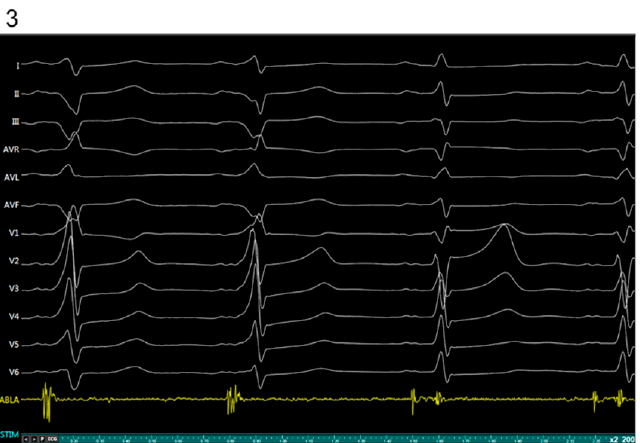
Figure 1. ( 1A ) During EPS, delta wave and QRS are (+) in lead V1, and ( − ) in inferior leads suggesting a left posteroseptal accessory pathway. Mapping the MA from the left side (retroaortic), showed earliest ventricle activation at the beginning of the delta wave. ( 1B ) Mapping the MA from inside the coronary sinus showed the earliest ventricle activation before the delta wave. ( 2A ) Venous angiography at the persistent left superior vena cava showed contrast flowing to the right atrium through a dilated coronary sinus. ( 2B ) Ablation catheter located at the point of effective ablation deep inside the dilated coronary sinus. ( 3 ) After mapping inside the giant CS, RF application during sinus rhythm at the earliest ventricular activation point removed the accessory pathway potential, showing separation of the atrial and ventricular activations. With the elimination of the accessory pathway, the delta wave disappeared and there was also the widening of the PR interval and normalization of the QRS